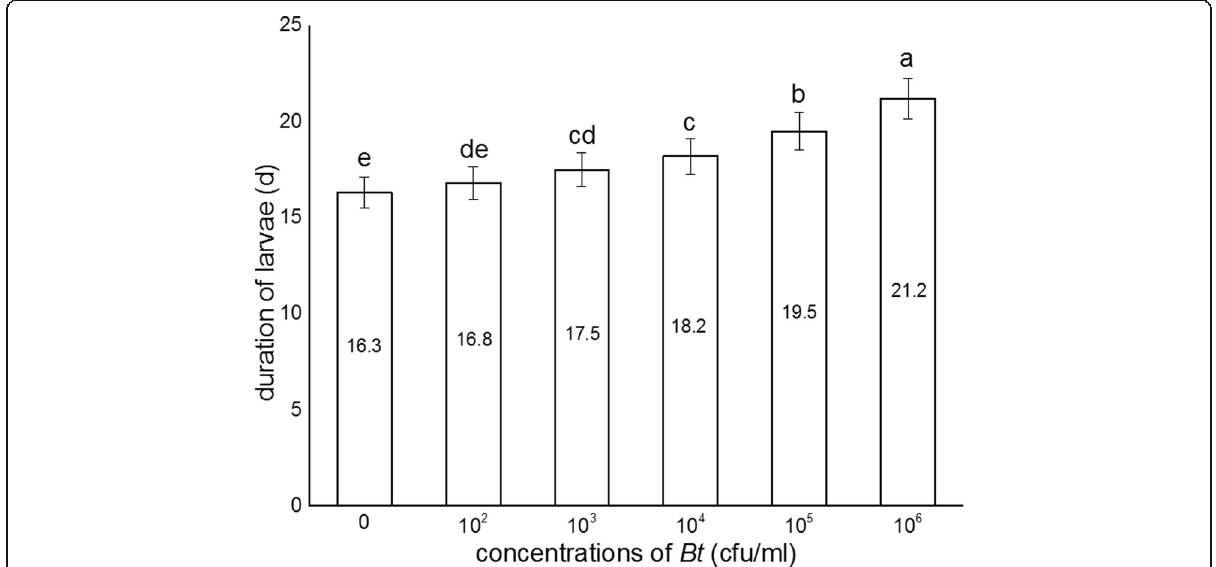
Fig. 3 Effect on Bt CAB109 duration of larvae of S. exigua